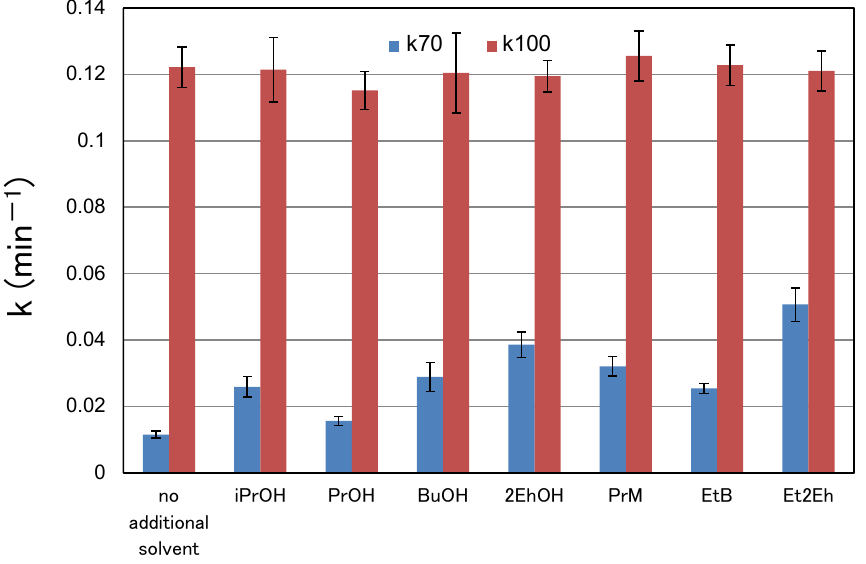
Figure 7. The k70 and k100 values for paint samples with different solvent compositions.